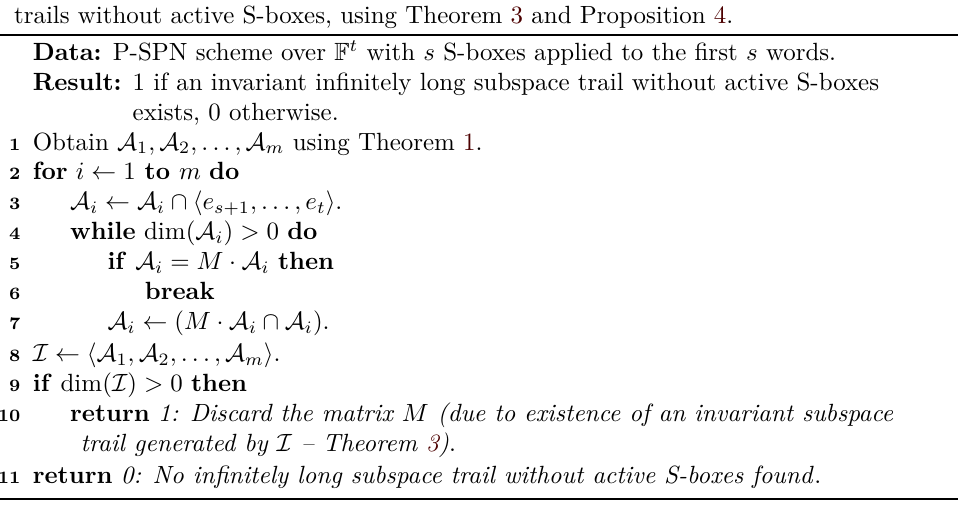
Algorithm 1: Determining the existence of invariant infinitely long subspace trails without active S-boxes, using Theorem 3 and Proposition